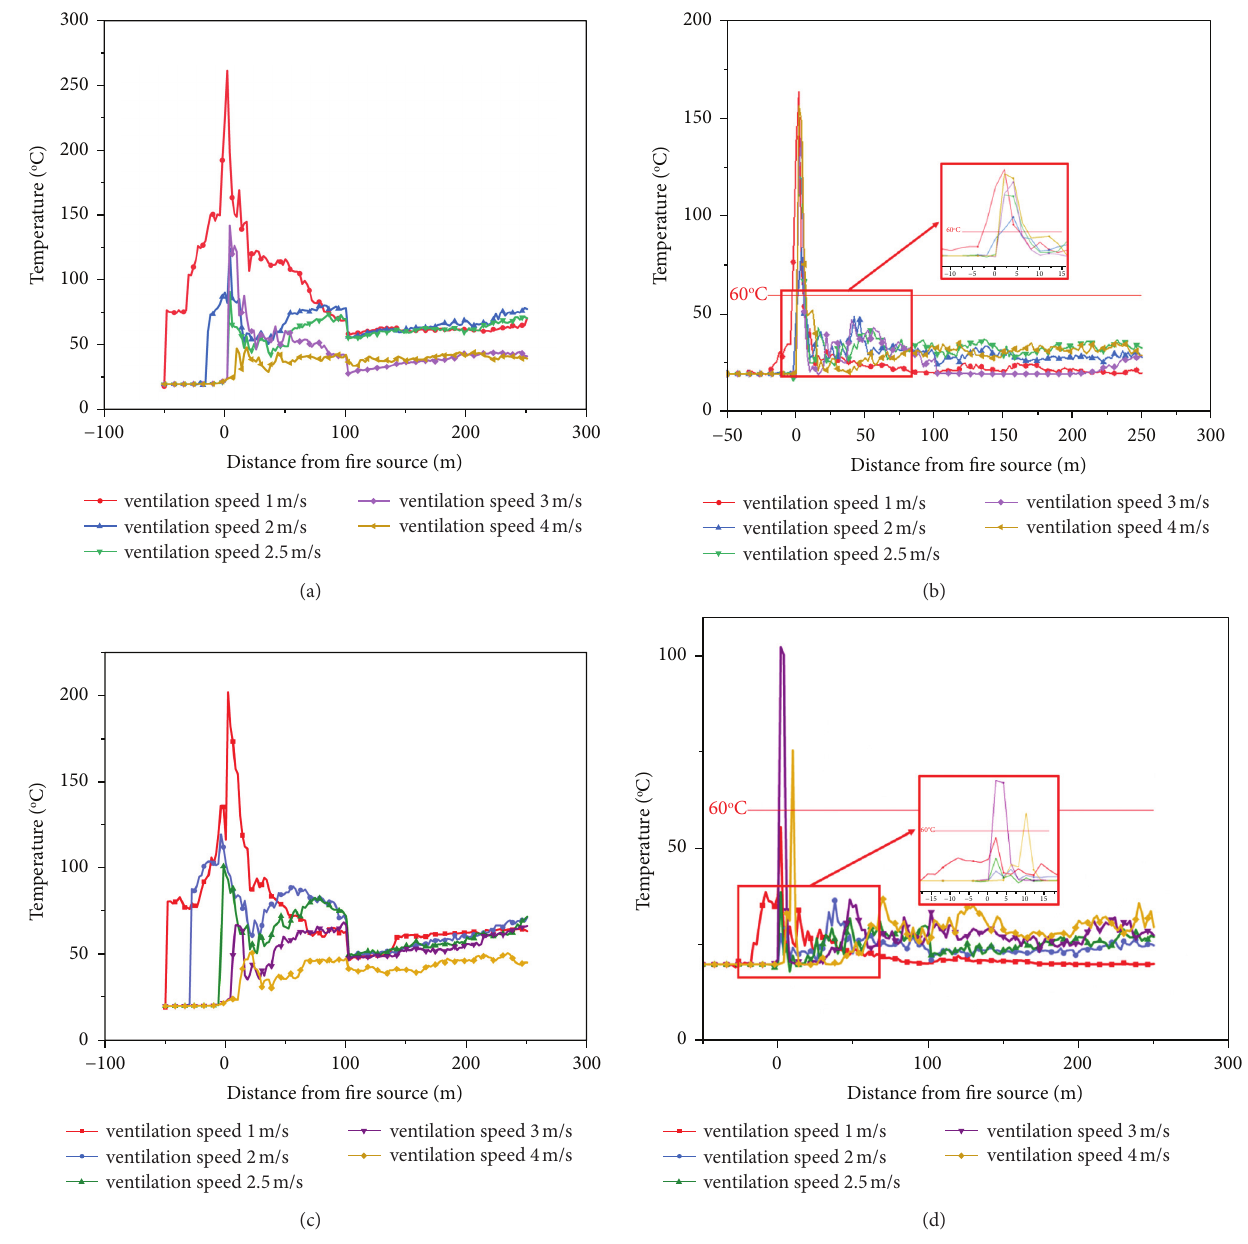
Figure 5: Variation of temperature at different heights in curvature 1/500 and 1/860 tunnels under different longitudinal ventilation speeds. (a) Variation of vault temperature in curvature 1/500 tunnel under different longitudinal ventilation speeds and variation of vault temperature in curvature 1/860 tunnel under different longitudinal ventilation speeds. (b) Variation of eye height temperature in curvature 1/500 tunnel under different longitudinal ventilation speeds and variation of eye height temperature in curvature 1/860 tunnel under different longitudinal ventilation